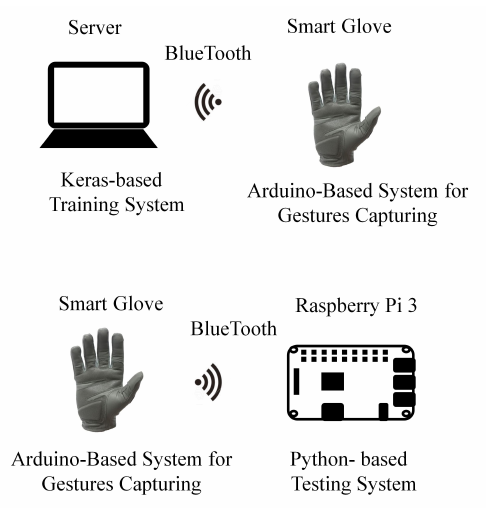
Figure 13. Setup of the experiments. Table 3. The size (in number of gestures) of each gesture class in the training and testing sets for the experiments considered in this study.